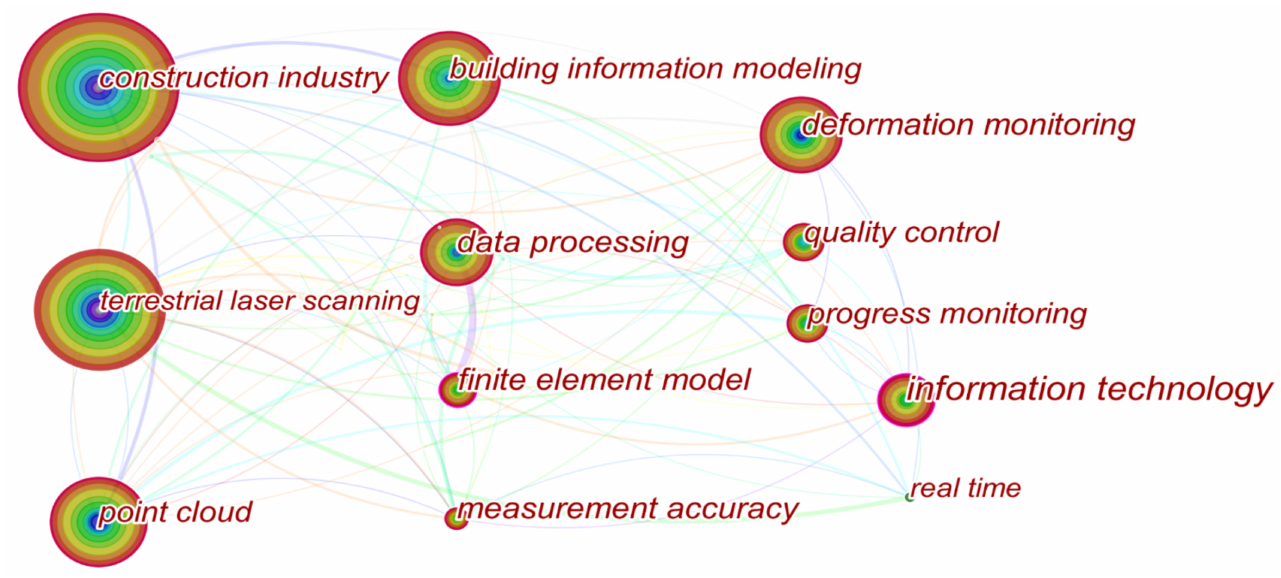
Figure 5. Network of co-occurrence keywords.